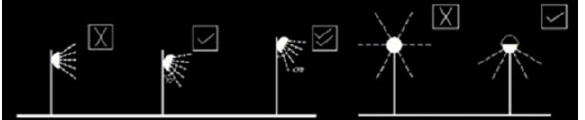
Figure 1. Right and wrong applications of armature (Chamber of Electrical Engineers,